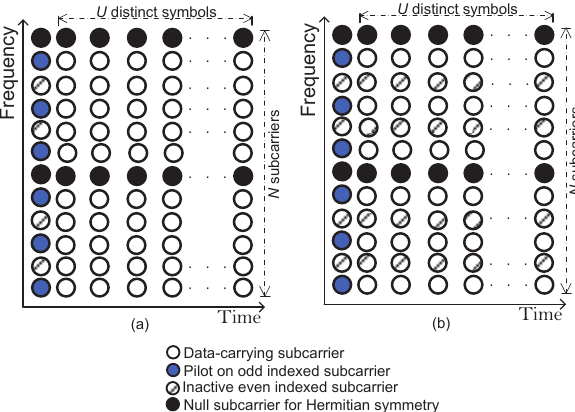
Figure 1. An illustration of a pilot-assisted (PA) frame in ( a ) direct-current biased optical orthogonal frequency division multiplexing (DCO-OFDM) and ( b ) asymmetrically clipped O-OFDM